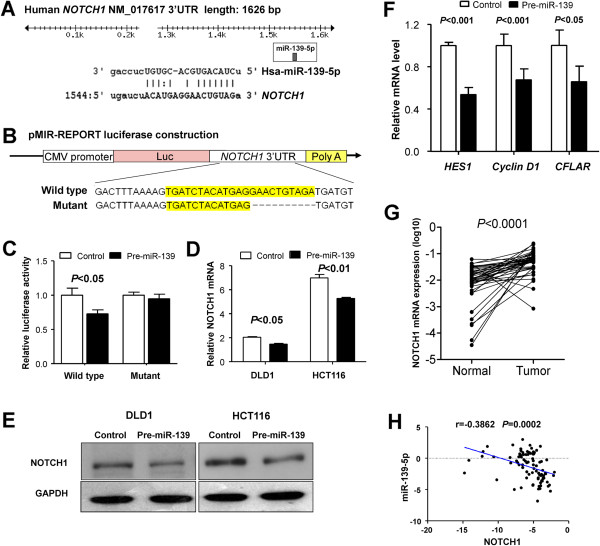
NOTCH1 is a direct target of miR-139-5p in colon cancer. (A) Human NOTCH1 3’UTR binding site for miR-139-5p. (B) The miR-139-5p wild type binding sequence or its mutated form was inserted into C-terminal of the luciferase gene to generate pMIR-NOTCH1-3’UTR or pMIR-NOTCH1-mut-3’UTR, respectively. (C) miR-139-5p targeted the wild-type but not the mutant 3’UTR of NOTCH1. The data are means ± SD. (D) Ectopic expression of miR-139-5p downregulated NOTCH1 mRNA expression in DLD1 and HCT116 cells as determined by quantitative RT-PCR. (E) miR-139-5p decreased NOTCH1 protein level in DLD1 and HCT116 by western blot. (F) miR-139-5p significantly suppressed NOTCH1 downstream effectors including hairy and enhancer of split-1 (HES1), cyclin D1 and FADD-like apoptosis regulator (CFLAR) transcription. (G) Expression of NOTCH1 is significantly upregulated in primary colorectal tumors compared with their adjacent normal tissues (n = 45). (H) Scatter plots showing the inverse association between miR-139-5p level and NOTCH1 mRNA expression.